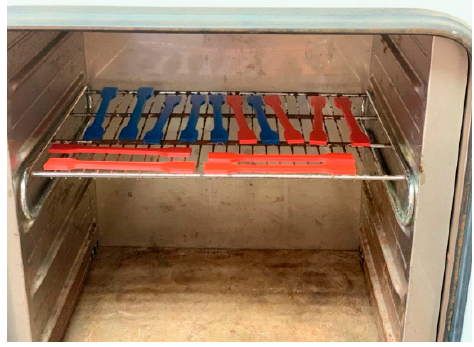
Figure 3. Specimen setup in the dryer.